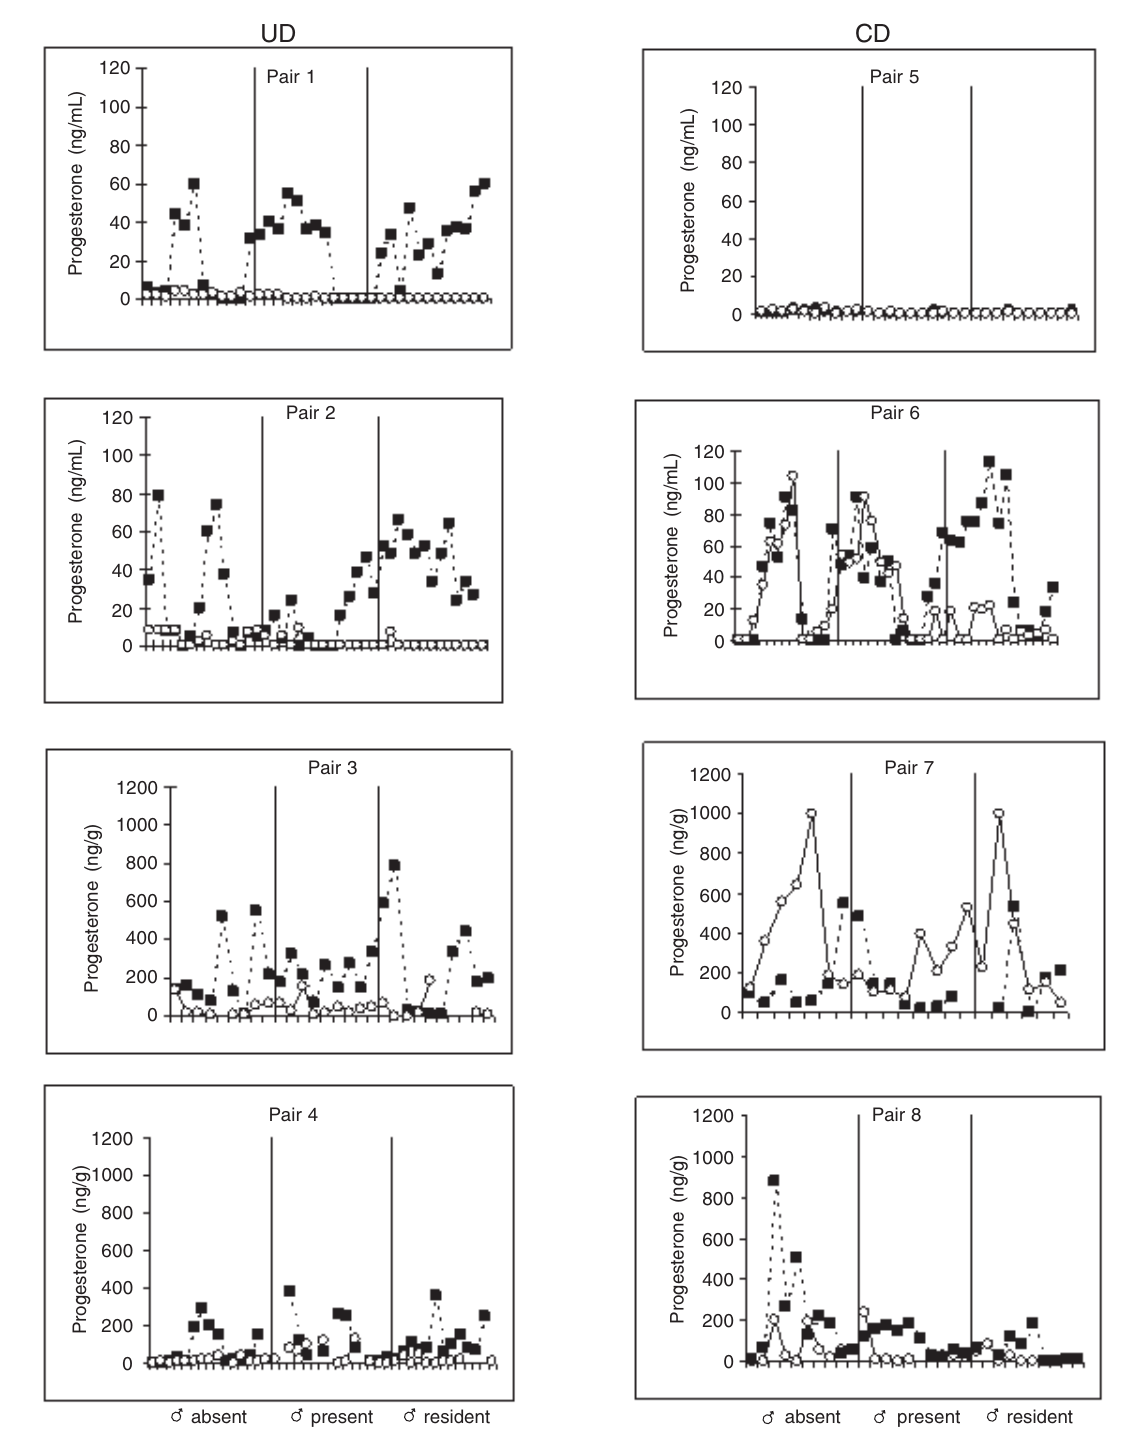
Figure 3. Progesterone levels in 8 Callithrix jacchus female pairs during the three 5-week study periods. The hormone was measured in plasma (ng/mL) for pairs 1, 2, 5, and 6 or in feces (ng/g) in pairs 3, 4, 7, and 8, collected twice a week. Squares indicate dominant females and circles subordinate females. Straight lines indicate the end of a 5-week period and the beginning of the next. UD = uncontested dominance; CD =